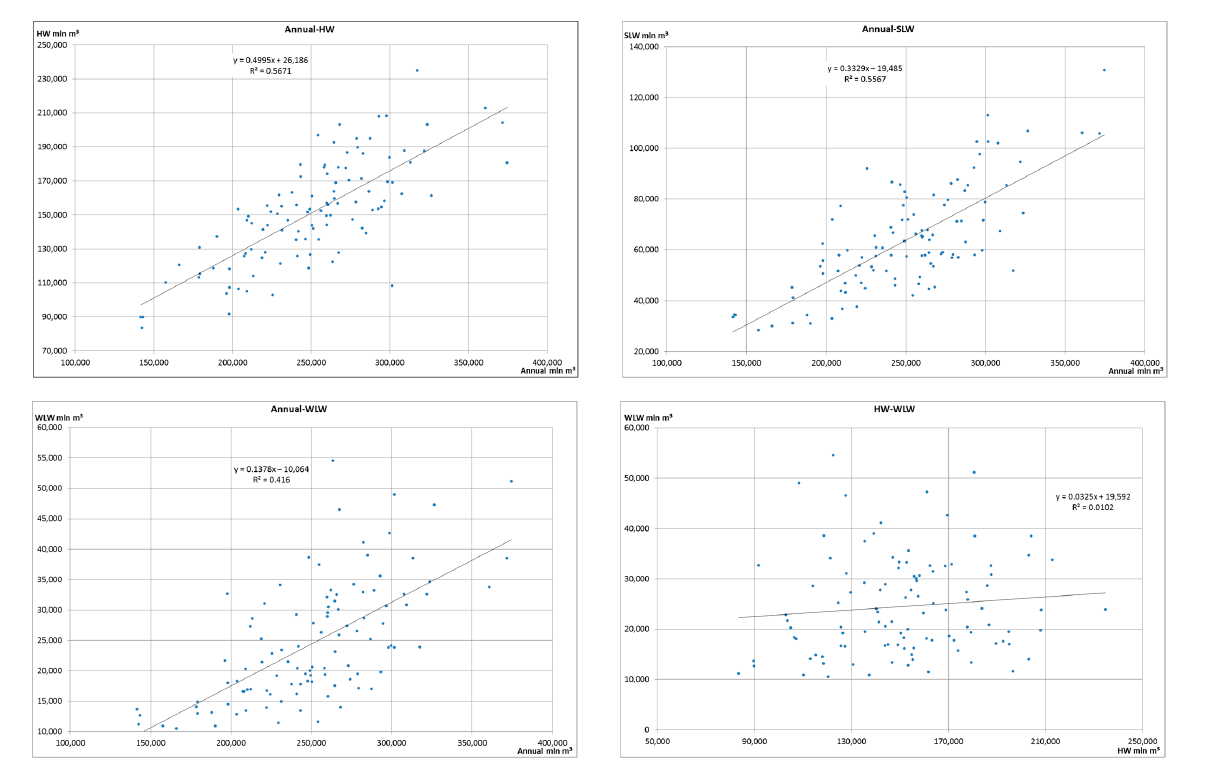
Figure 6. Scatterplots—Kuibyshevskoye reservoir. Figure 7 shows similar diagrams for the corresponding seasonal inflow pairs for the cascade as a whole.